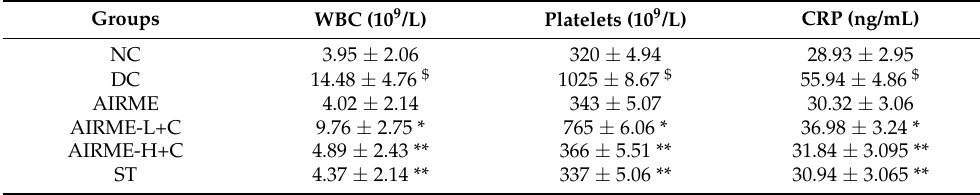
Table 3. Effect of AIRME on white blood cells (WBC) and platelets count, and changes in serum C-reactive protein (CRP) in rats. Values represented as mean ± SD ( n = 6). $ denotes significant at p < 0.05 compared with normal control (NC). Results are significant at p < 0.05 (*) and p < 0.01 (**) compared with disease control